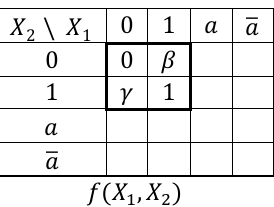
Figure 7. Function table for the function of example 2